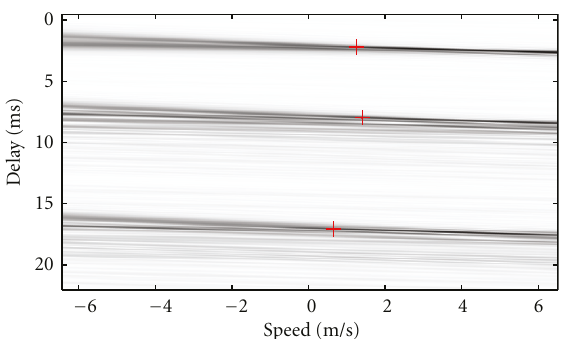
Figure 4: Wideband ambiguity function of the received LFM probing signal in the KAM08 experimental data. The crosses represent the delay-speed coordinates of the three detected path groups.